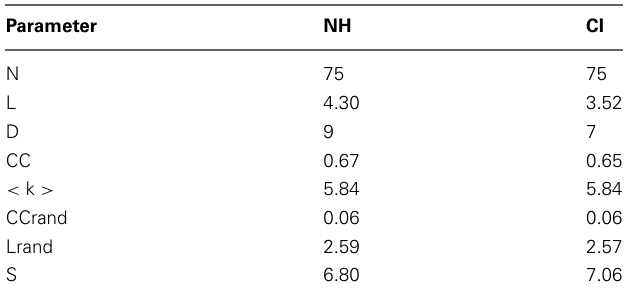
Table 2 | Summary of results of word matched correlation networks